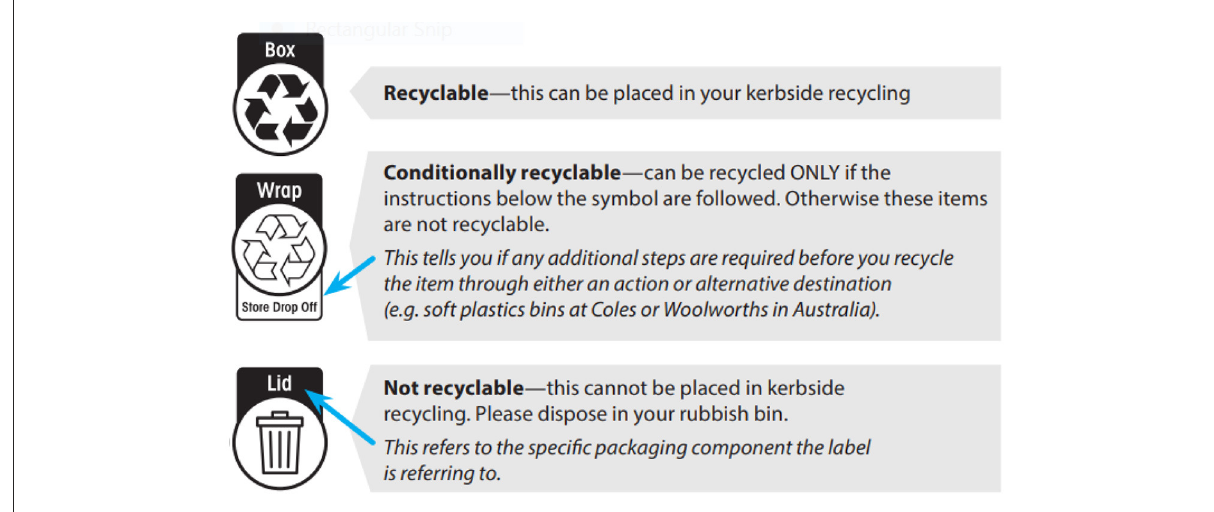
FIGURE1 Example of the Australasian recycling label to be featured on 80% of supermarket products by 2023. The label will also be used for business-business